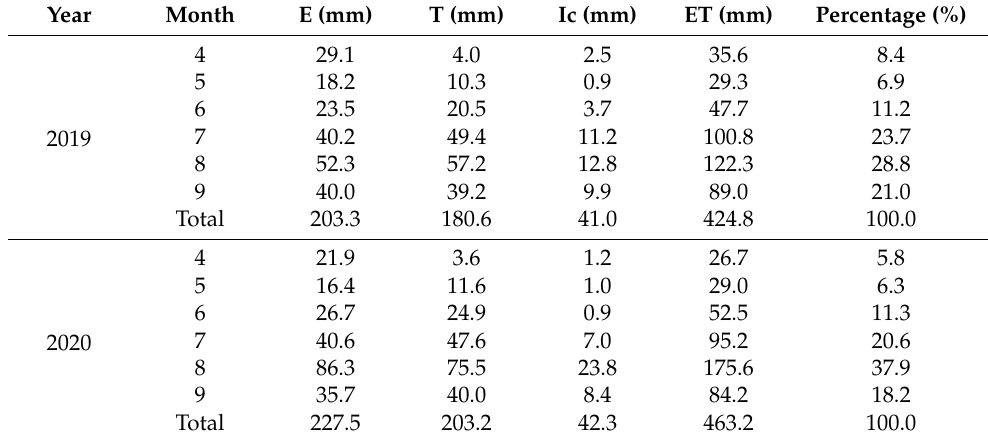
Table 3. Variation of monthly evapotranspiration of apples from April to September in 2019 and